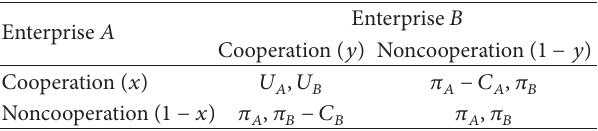
Table 1: The general payoff matrix for enterprise 𝐴 and enterprise 𝐵